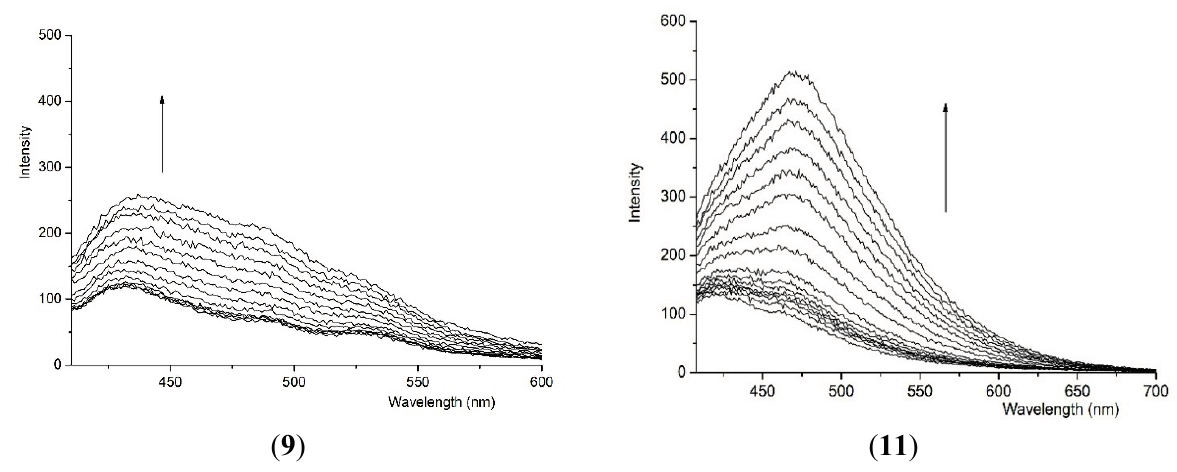
Figure 3. Fluorescence response of compounds ( 1 , 2 , 3 , 6 , 9 and 11 ) (4.0 × 10 − 5 mol·L − 1 ) upon the addition of an acetate anion ( − 2.0 × 10 − 3 mol·L − 1 ); arrows indicate the increasing